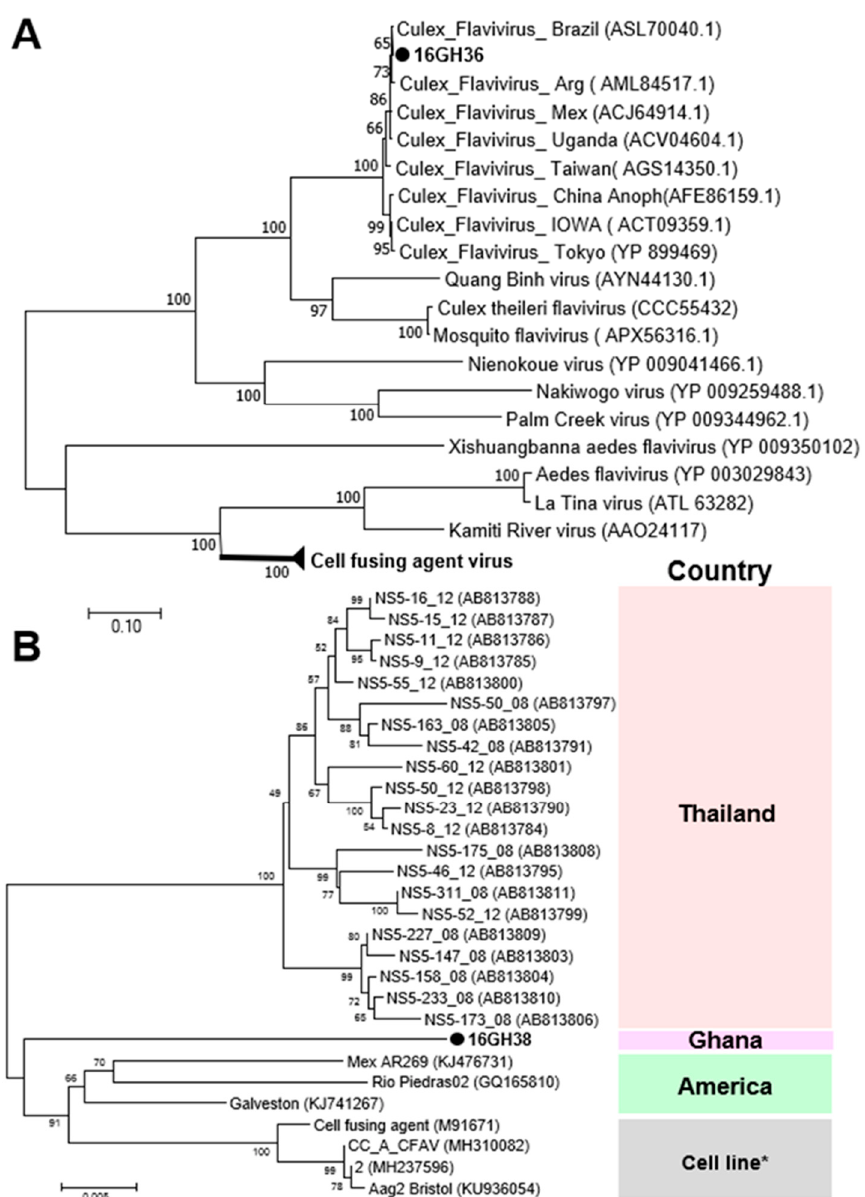
Figure 4. Phylogenetic analysis of Culex flavivirus (CxFV) and cell-fusing agent virus (CFAV). MAFFT 7 online version [27] and the Gblocks program [28] were combined to extract the conserved amino acid domains in CxFV and CFAV genome sequences with Genbank accession numbers LC504568 and LC496857, respectively. The conserved domains were subsequently used in constructing a maximum likelihood phylogenetic tree, with 1000 boostraps, to determine the relationship between CxFV detected in Ghana and other known CxFV and the cell fusing agent virus clade ( A ). The partial nucleotide sequence of NS5 domains of CFAV (Genbank accession number LC496857) was used in determining the phylogenetic position of CFAV from Ghana in relation to previously reported CFAV strains ( B ). Bootstrap support, from 1000 bootstrap replicates, are indicated by values on the branches.